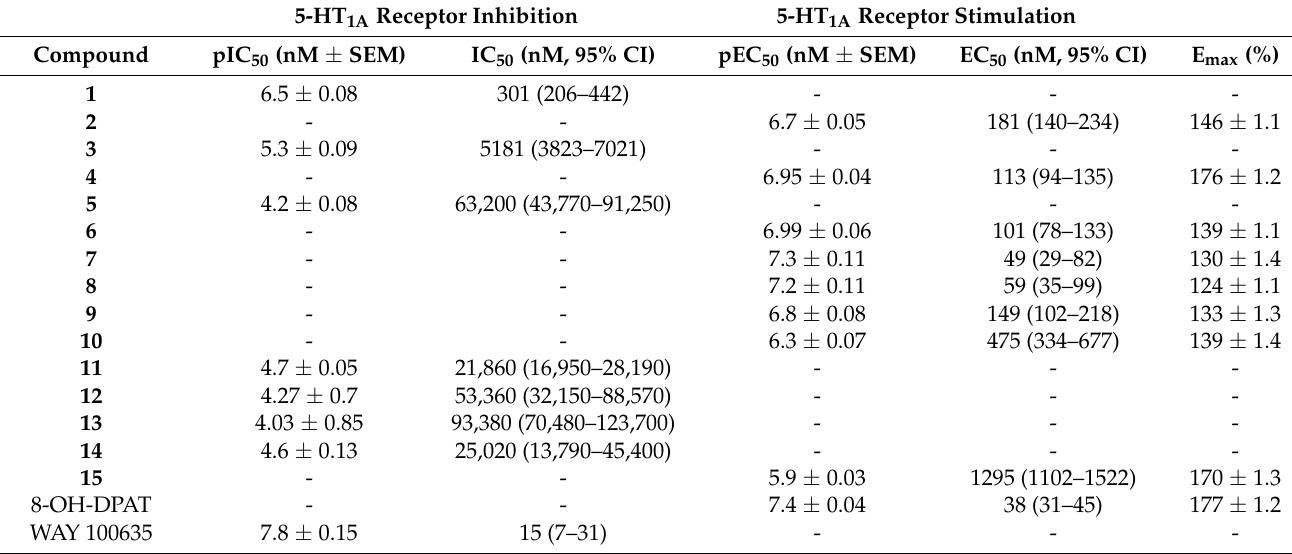
Table 5. Functional data for compounds 1 – 15